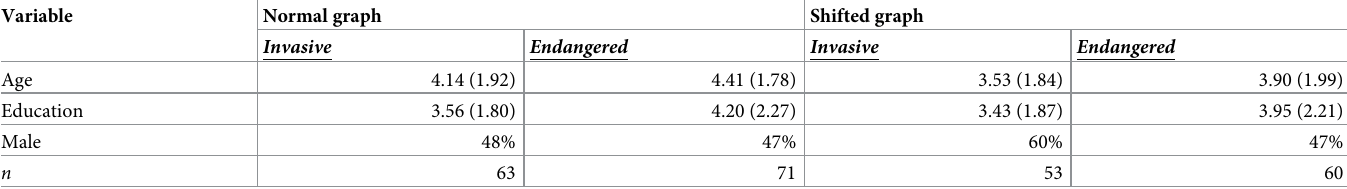
Table 1. Descriptive statistics (mean score and standard deviation; the percentage for ‘male’) of the demographic characteristics. Variable